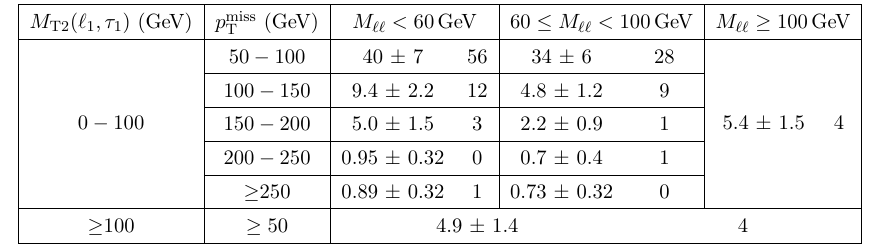
Table 16 . Category E: expected and observed yields in events with one SS e or (cid:22) and one (cid:28) each bin, the (cid:12)rst number corresponds to the expected yield and its uncertainty, and the second denotes the observed yield. The uncertainty denotes the total uncertainty in the yield.